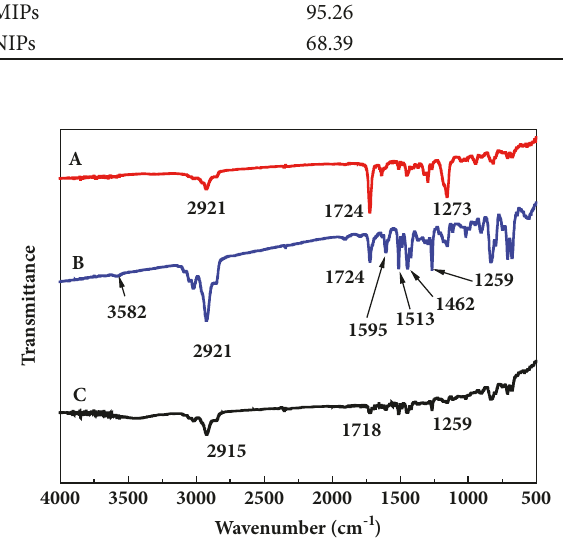
Figure 3: FT-IR spectra of (A) P MIPs, and (C) eluted